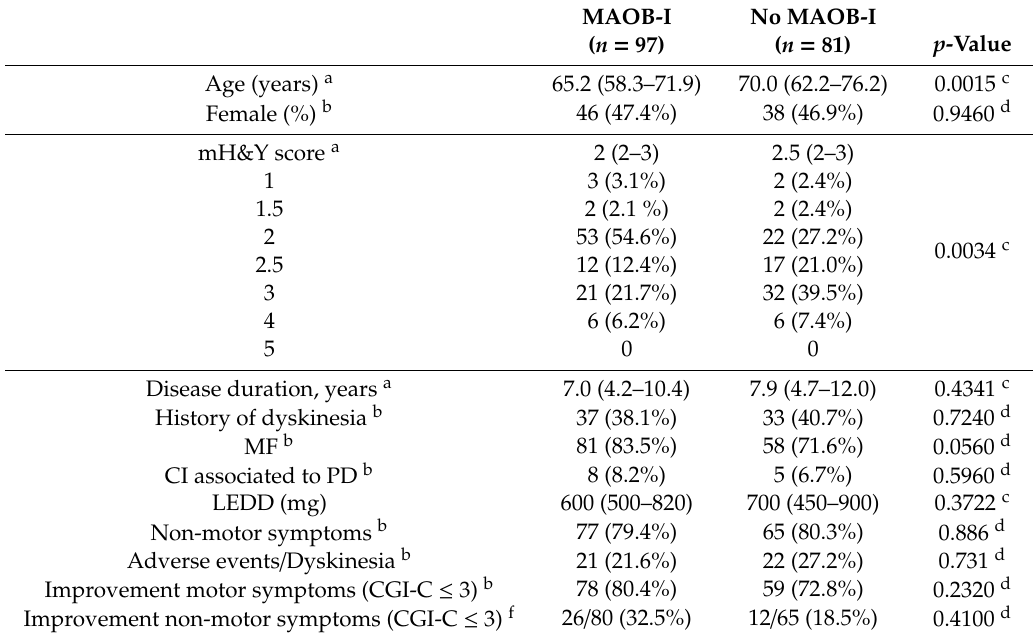
Table 5. Comparison between patients with or without a previous